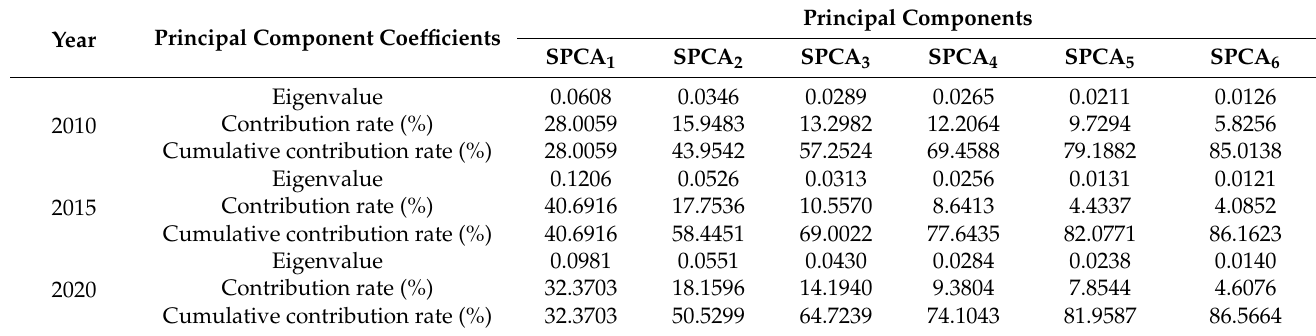
Table 4. Results of spatial principal component analysis.